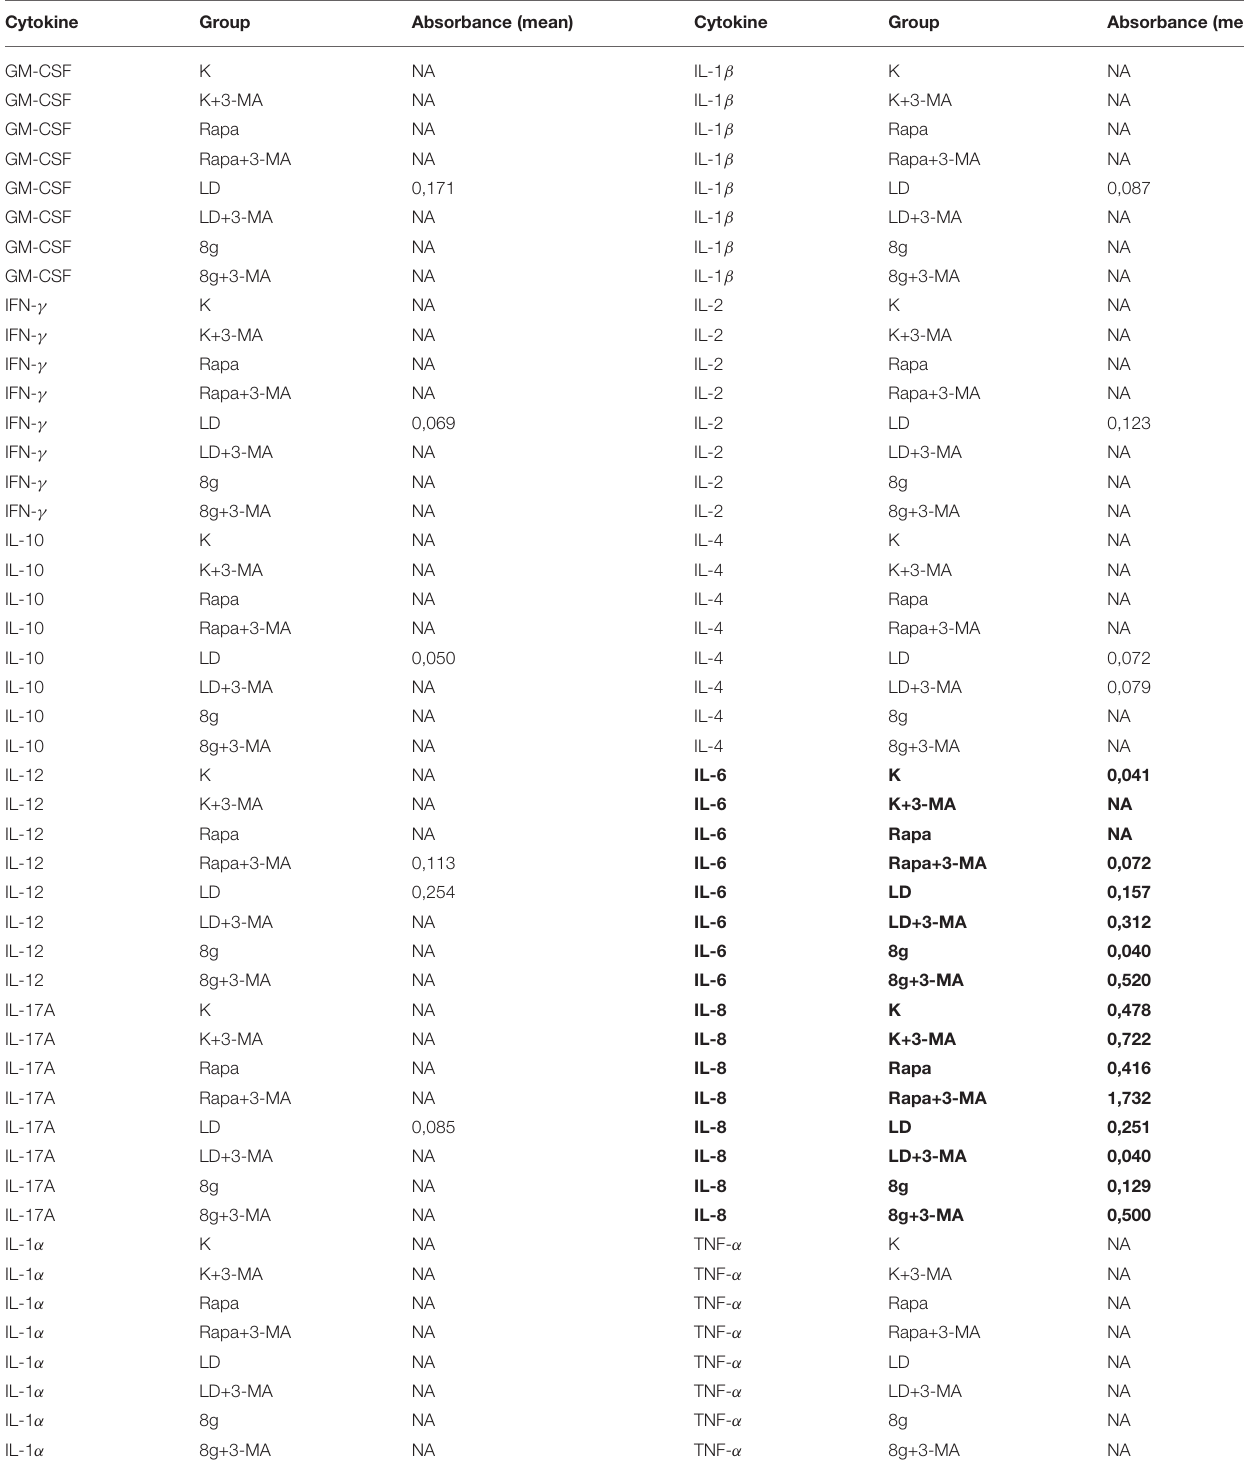
TABLE 2 | Absorbance values of tested cytokines. Cytokine Group Absorbance (mean) Cytokine Group Absorbance